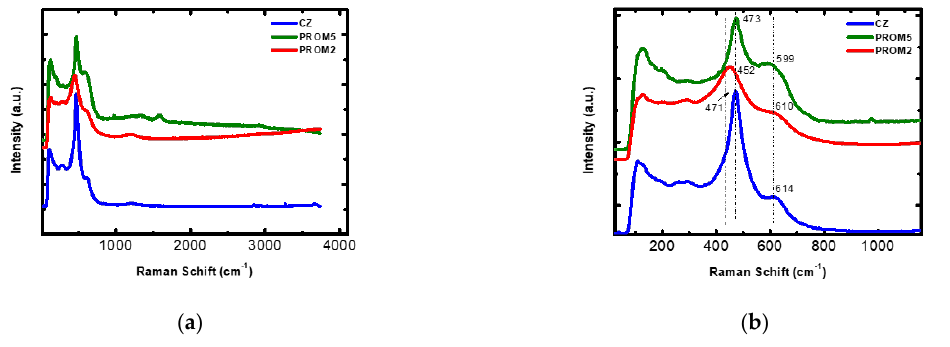
Figure 8. Raman spectrum of the samples CZ, PROM2, PROM5 ( a ) 10-4000cm −1 ; ( b ) 10-1100cm −1 . Finally, the bands at 1205, 1207, 1225 cm −1 for CZ, PROM2 and PROM5 respectively, and the low frequency bands at 614, 610 and 599 cm −1 for CZ, PROM2 and PROM5, as well, correspond to the defect-induced bands Ce-O of the cubic phase of the CZ substrate. These spectral changes, are in accordance to XRD results, where [220] and [311] crystal planes are affected by the addition of the catalytic phase on the substrate, indicating that the possible doping and Ce ion substitution might have taken place upon substrate im- pregnation.